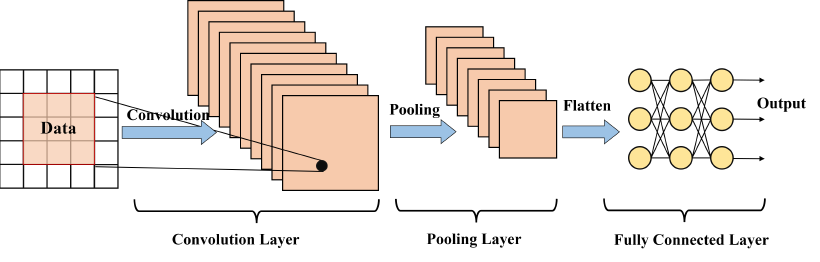
Figure 2. Typical structure of CNN network.